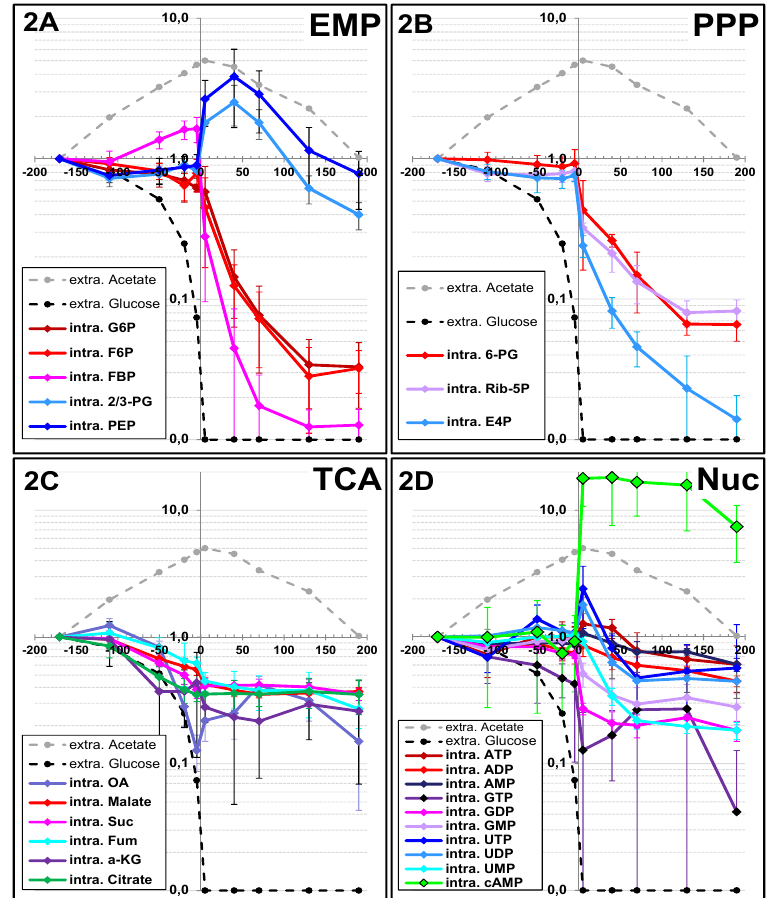
Figure 2. Changes in metabolite pool sizes during the glucose/acetate